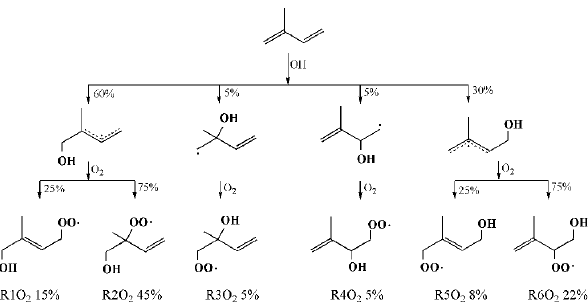
Scheme 1. Mechanisms for the formation of six hydroxy isoprene peroxyl radicals (R1O 2 through R6O 2 ) and their distributions (%) from the OH-initiated oxidation of isoprene (top molecule) in the absence of NO x (adapted from Jenkin et al.,